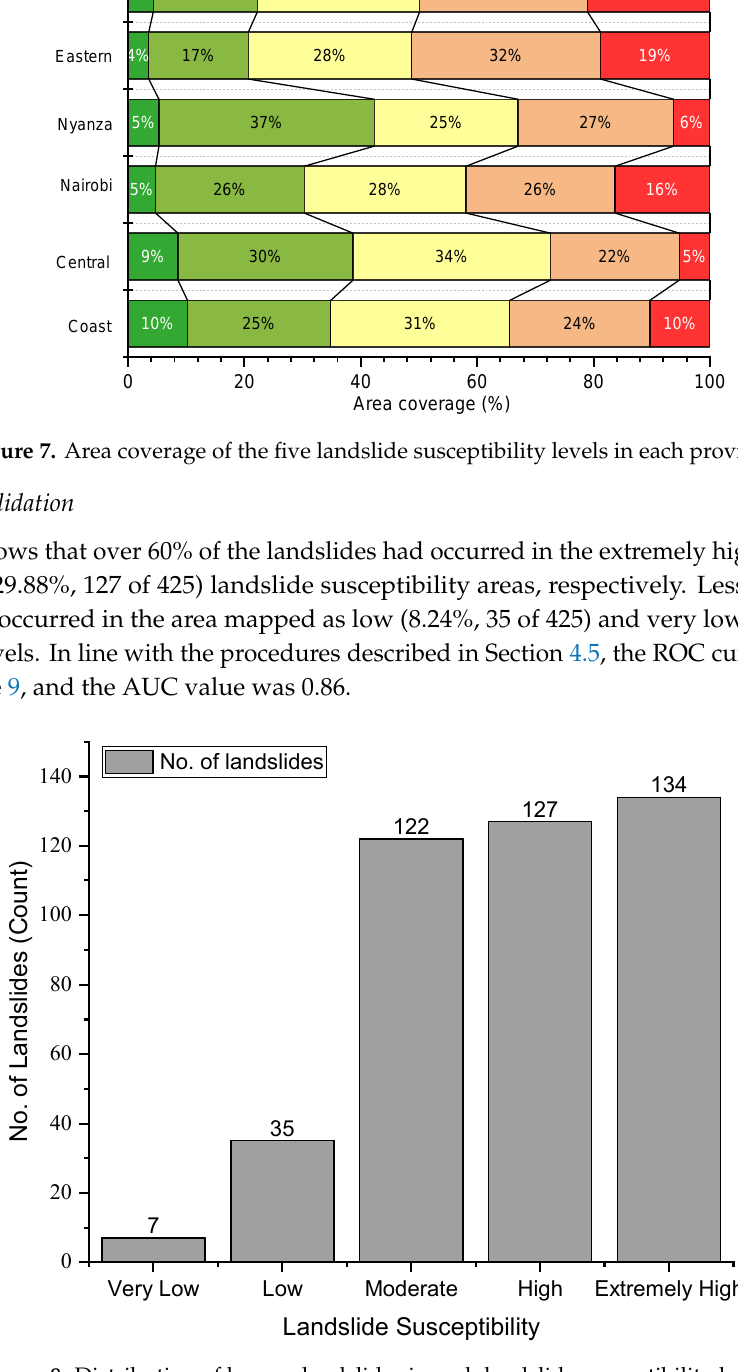
Figure 8. Distribution of known landslides in each landslide susceptibility level.